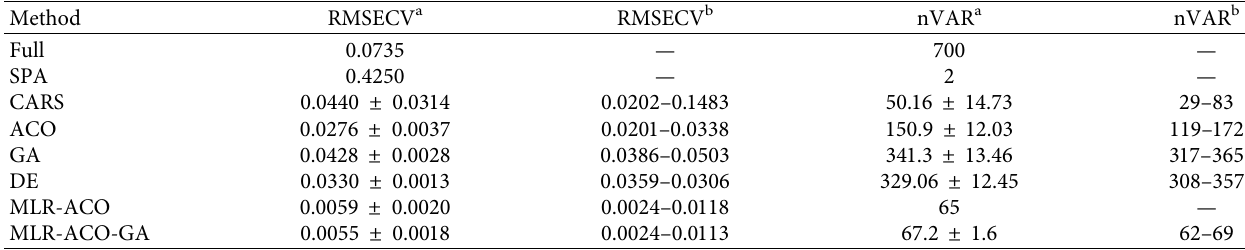
Table 3: Te results of diferent methods on the corn protein dataset.